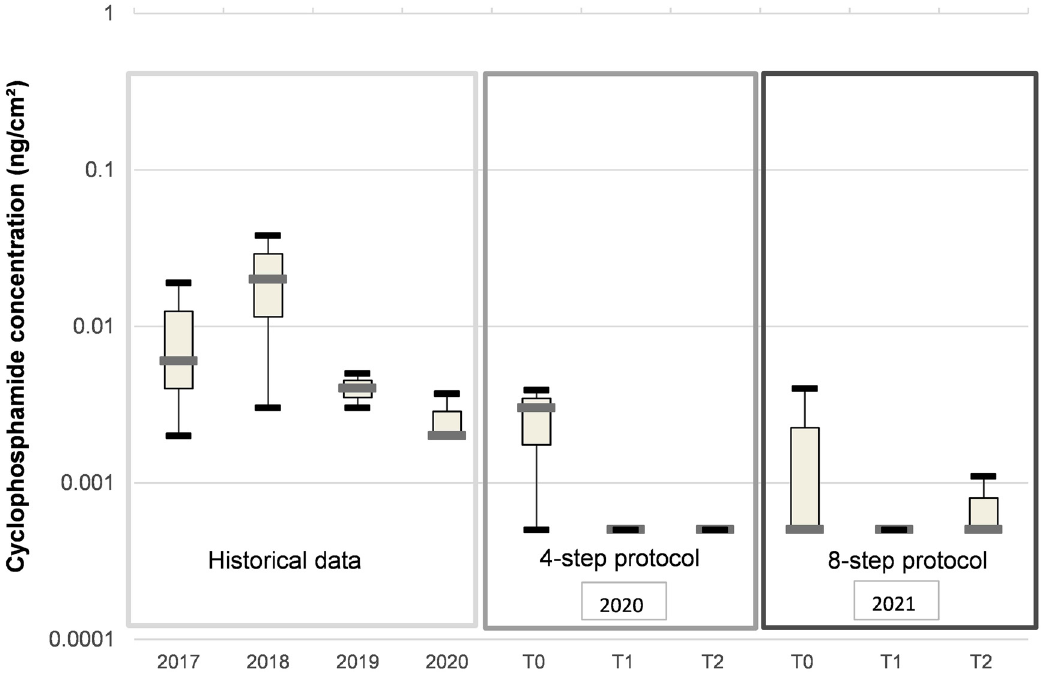
Figure 3: Cyclophosphamide contamination on cyclophosphamide storage shelves (ng/cm 2 ) (n=3 sampling sites). 2017 – 2020 data obtained fromhistoricalsurfacemonitoringresults.Thefour-stepdecontaminationprotocolwasconductedin2020andtheeight-stepprotocolin2021. Minimum, 25th, 50th, 75th percentile and maximum are shown. Logarithmic scale used. The limit of detection was 0.001 ng/cm 2